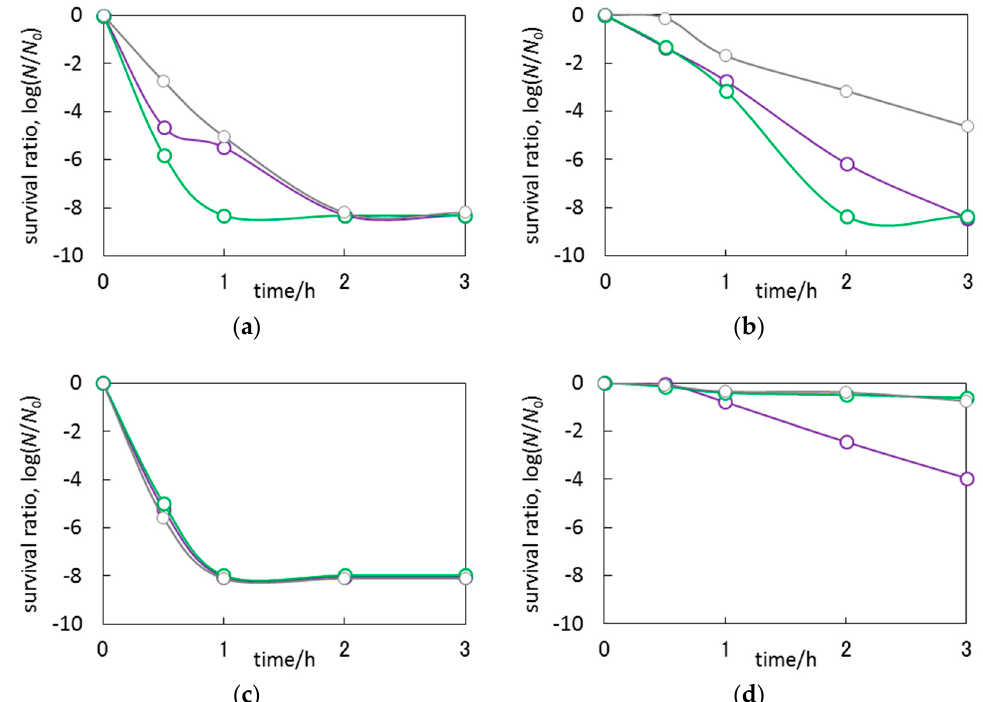
Figure 12. Survival ratio of E. coli K12 bacteria in the presence of 5 wt% Ag 2 O/ST01 ( a ), 1 wt% Ag 2 O/ST01 ( b ), Ag 2 O ( c ) and bare ST01 ( d ) under UV irradiation (purple, 300 < λ < 420 nm), vis irradiation (green, λ > 420 nm), and in the dark (grey).